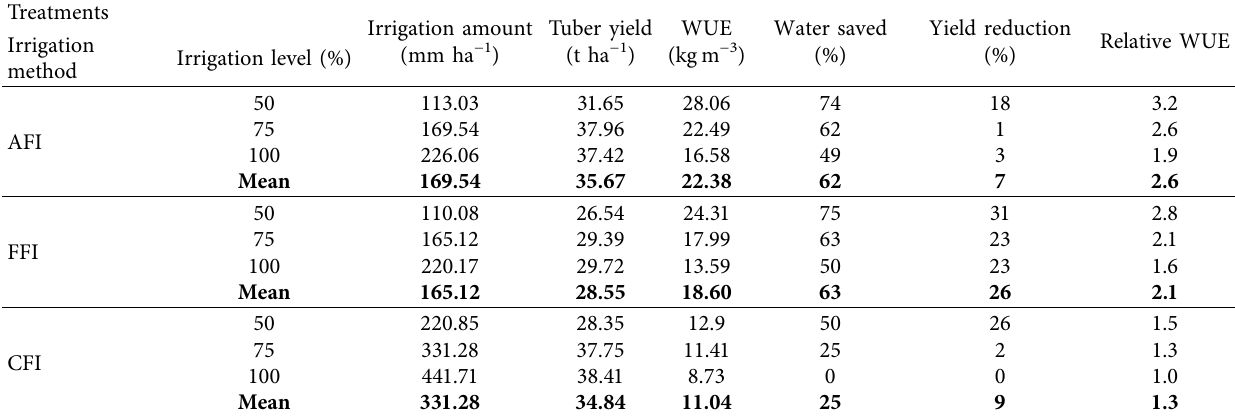
Figure 1: Weight of potato tubers (a) and plant height of potato (b) as affected by the interaction effect of irrigation method by water level. Table 4: The amount of irrigation water saved, tuber yield reduction, and relative water use efficiency with different irrigation methods and